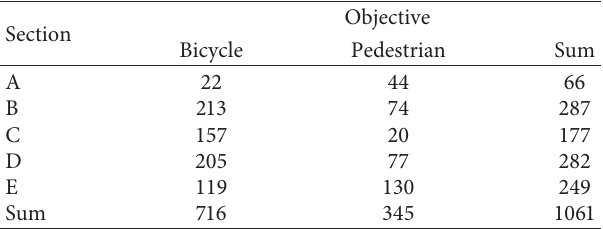
Table 7: Number of events according to section in scenario 1.